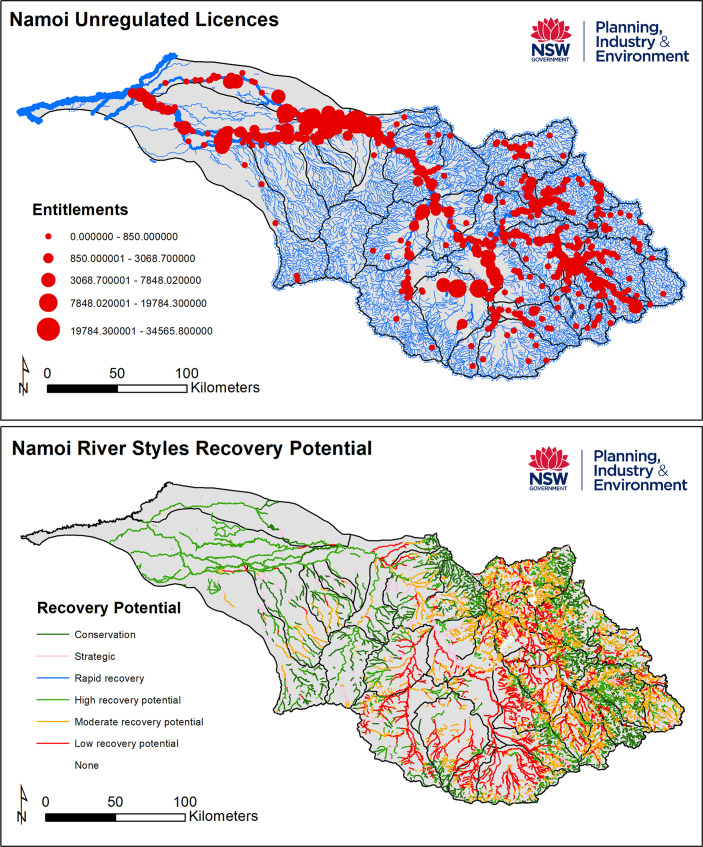
Matching geomorphic recovery potential to hydrological stress for water extraction rule-setting as part of Water Sharing Plans (WSPs).DPIE Water Risk assessment includes hydrology and geomorphic recovery potential. Shown for the Namoi Catchment in 2018.